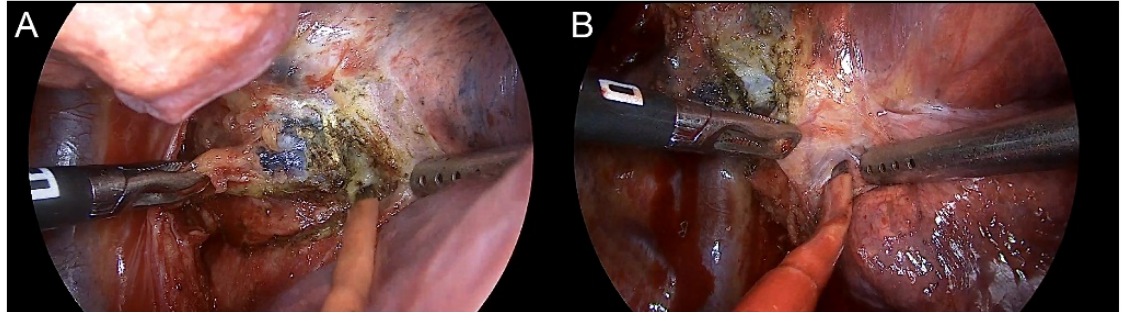
Figure 6. Dense fibrosis or calcification around the initial population cancer cells because of the response to TKI therapy. ( A ) Subcarinal lymph node with proven metastasis confirmed by endobronchial ultrasound biopsy. Residual metastatic lesions were identified in the pathologic report. ( B ) Interlobar lymph node with suspicious metastases revealed using preoperative PET-CT. Complete remission was reported in the final pathologic report.